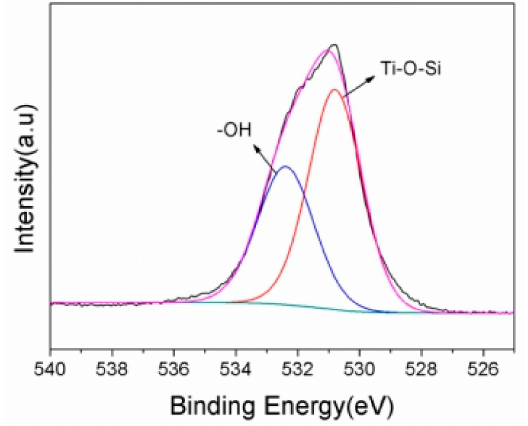
Figure 10. XPS spectra of O element in 10% GO / TiO 2 / Bent